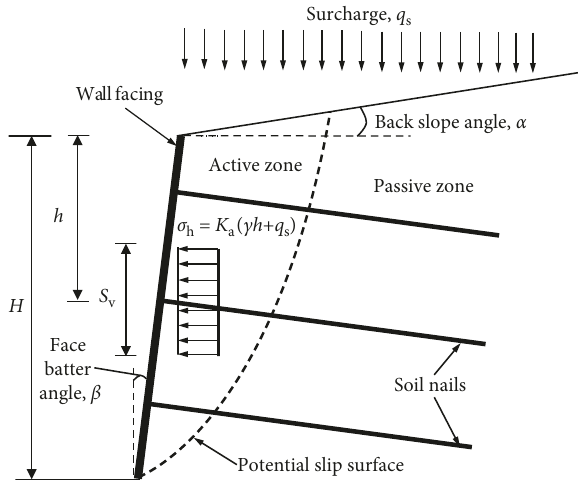
Figure 1: Geometry of soil nail walls and horizontal stress of soil acting on the wall. Table 1: Summary of wall geometry, soil properties, and nail arrangement for soil nail walls reported in the source documents. Data Wall group